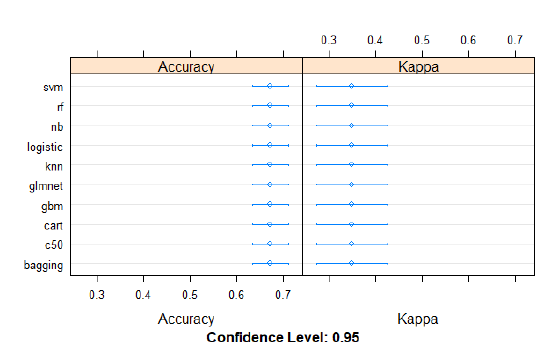
Figure 6. Experiment results with randomly selected